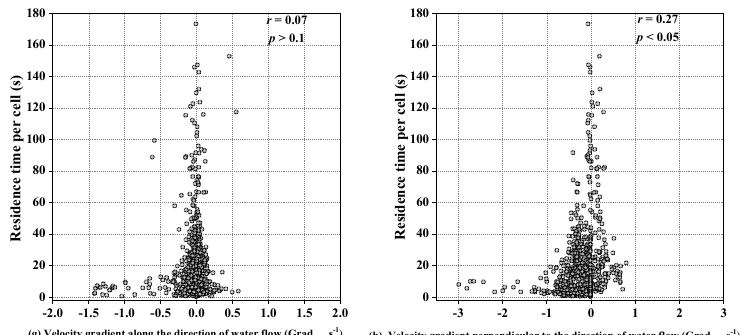
(f) Strain Rate (SR, s -1 )